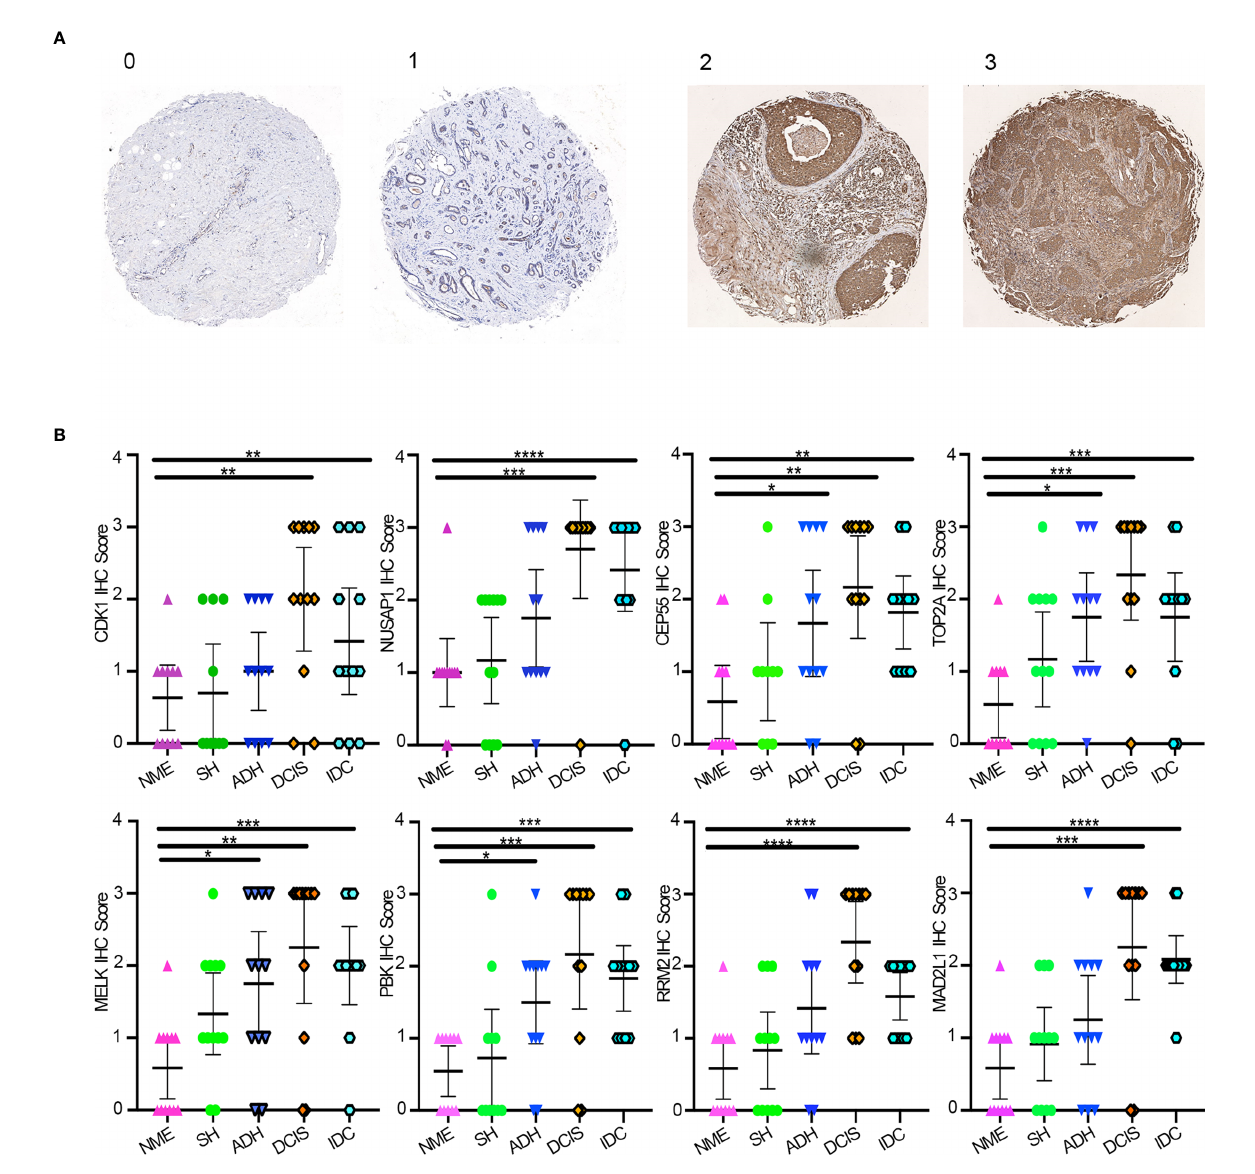
FIGURE 5 | (A) Average IHC score scale. (B) Average IHC score of eight hub genes using GraphPad Prism v8. One-way ANOVA was performed to determine statistical signi fi cance (*p < 0.05, **p < 0.01,***p < 0.001,****p < 0.0001). NME, normal mammary epithelium; SH, simple ductal hyperplasia; ADH, atypical ductal hyperplasia; DCIS, ductal carcinoma in situ; IDC, invasive ductal